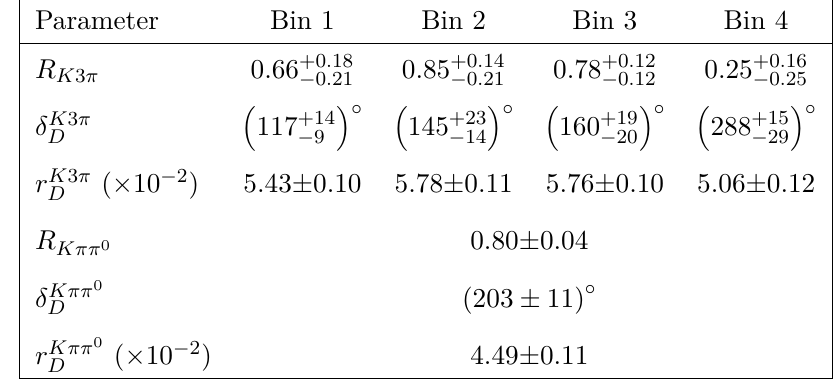
Figure 16 . Scans of ∆ χ 2 in the BESIII, CLEO-c and LHCb global fit in the ( R K 3 π , δ K 3 π ( R , δ Kππ 0 ) parameter space, showing the ∆ χ 2 = 2 . 30 , 6.18, 11.83 intervals, which corresponds Kππ 0 D to the 68 . 3% , 95 . 4% and 99 . 7% CLs in the two-dimensional parameter space.